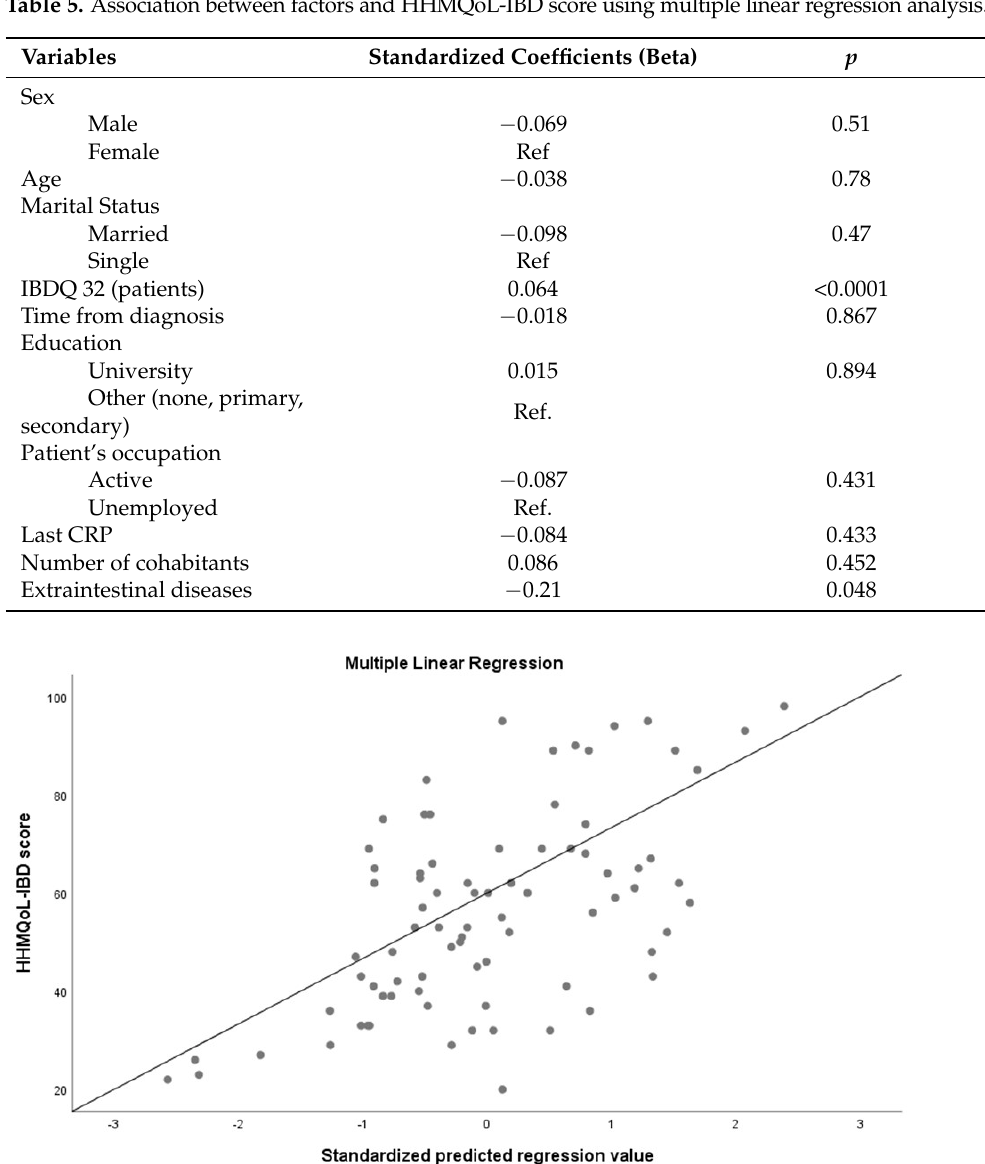
Table 5. Association between factors and HHMQoL-IBD score using multiple linear regression analysis.